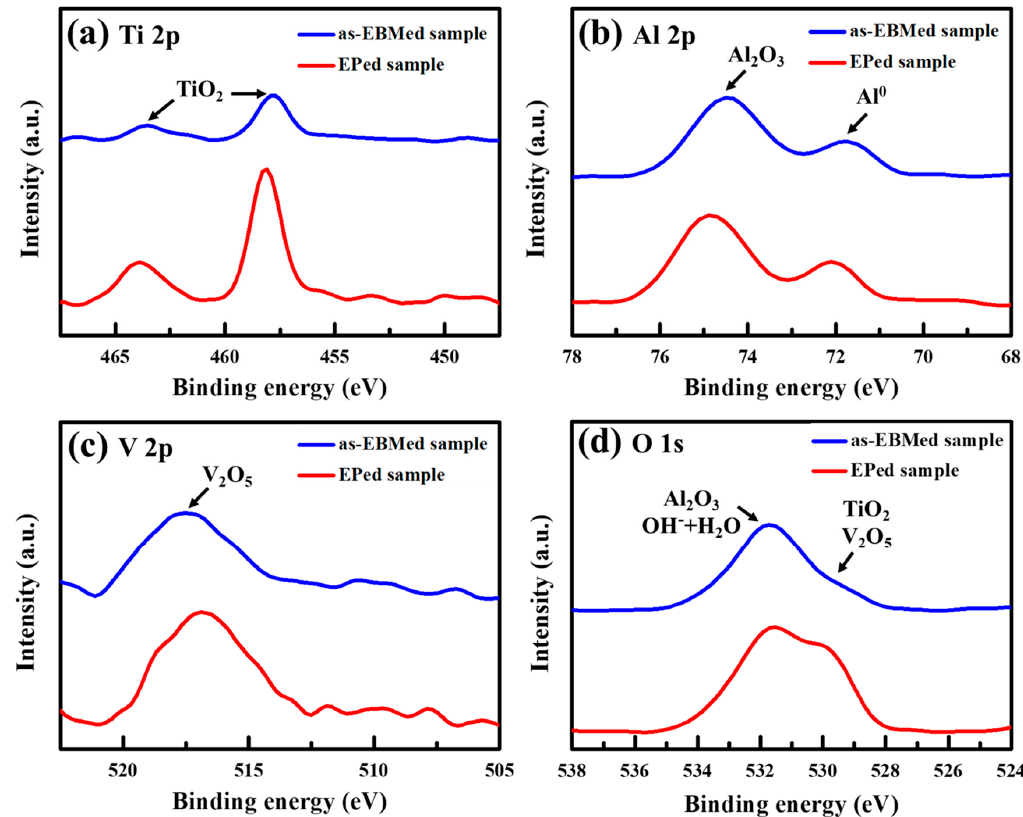
Figure 7. XPS spectrums of surface analysis before and after the EP: ( a ) Ti 2p; ( b ) Al 2p; ( c ) V 2p; and ( d ) O 1s peak.